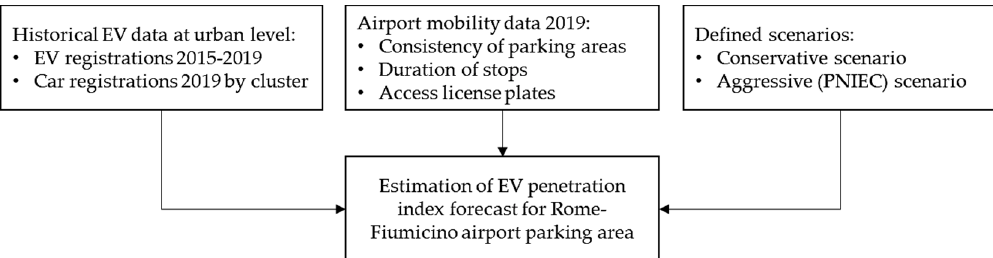
Figure 10. Summary of forecast methodology.